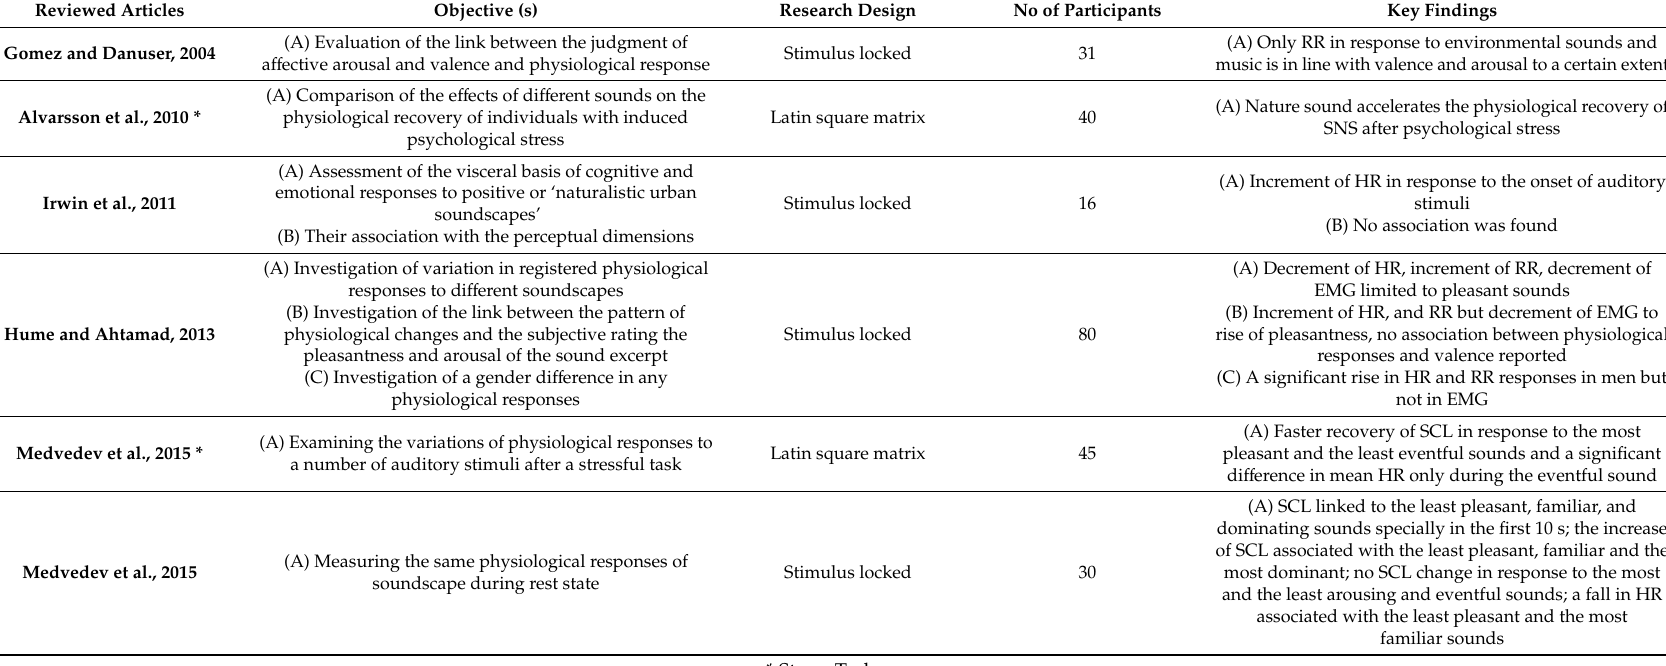
Table 2. Studies from 1990 to 2019 of the outcome of the psychophysiology of